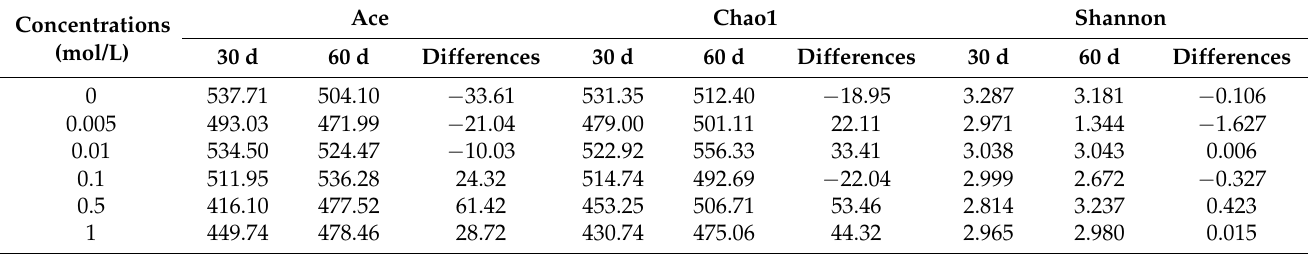
Table 4. Effect of pyrogallic acid on bacterial diversity.